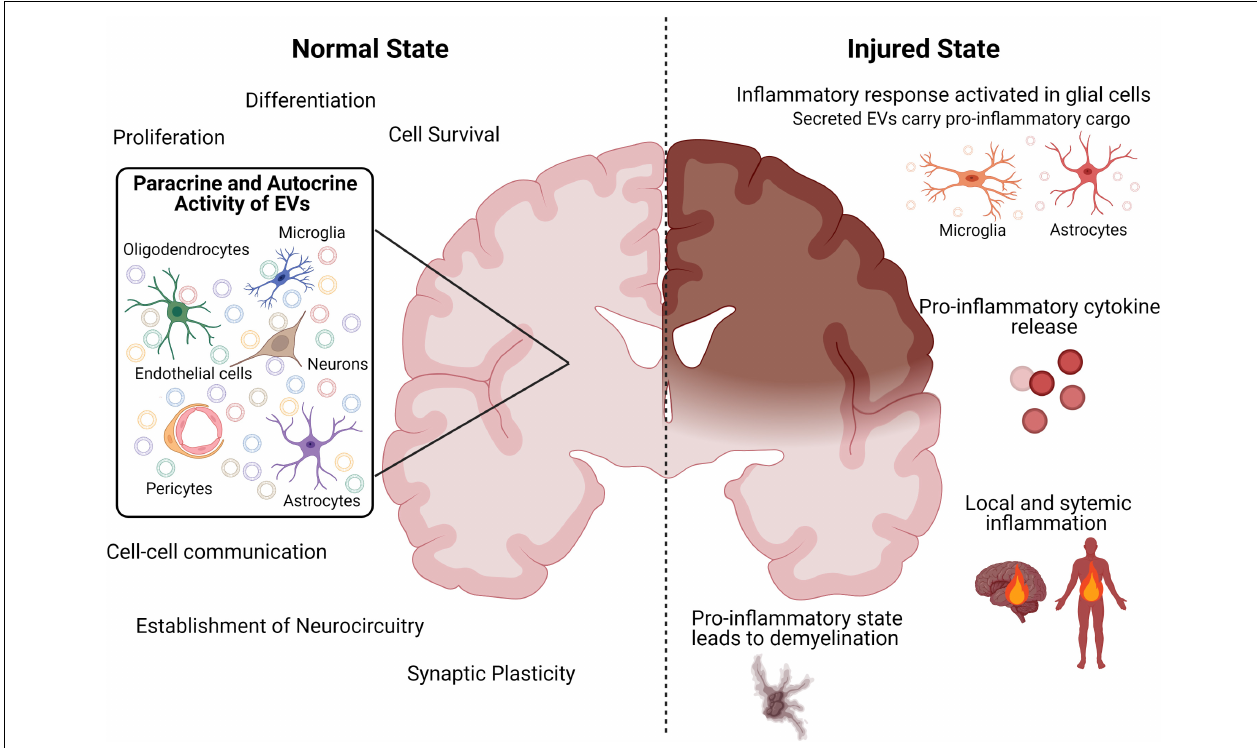
FIGURE 1 | Schematic diagram summarizing the role of EVs in the healthy and injured brain. Created with